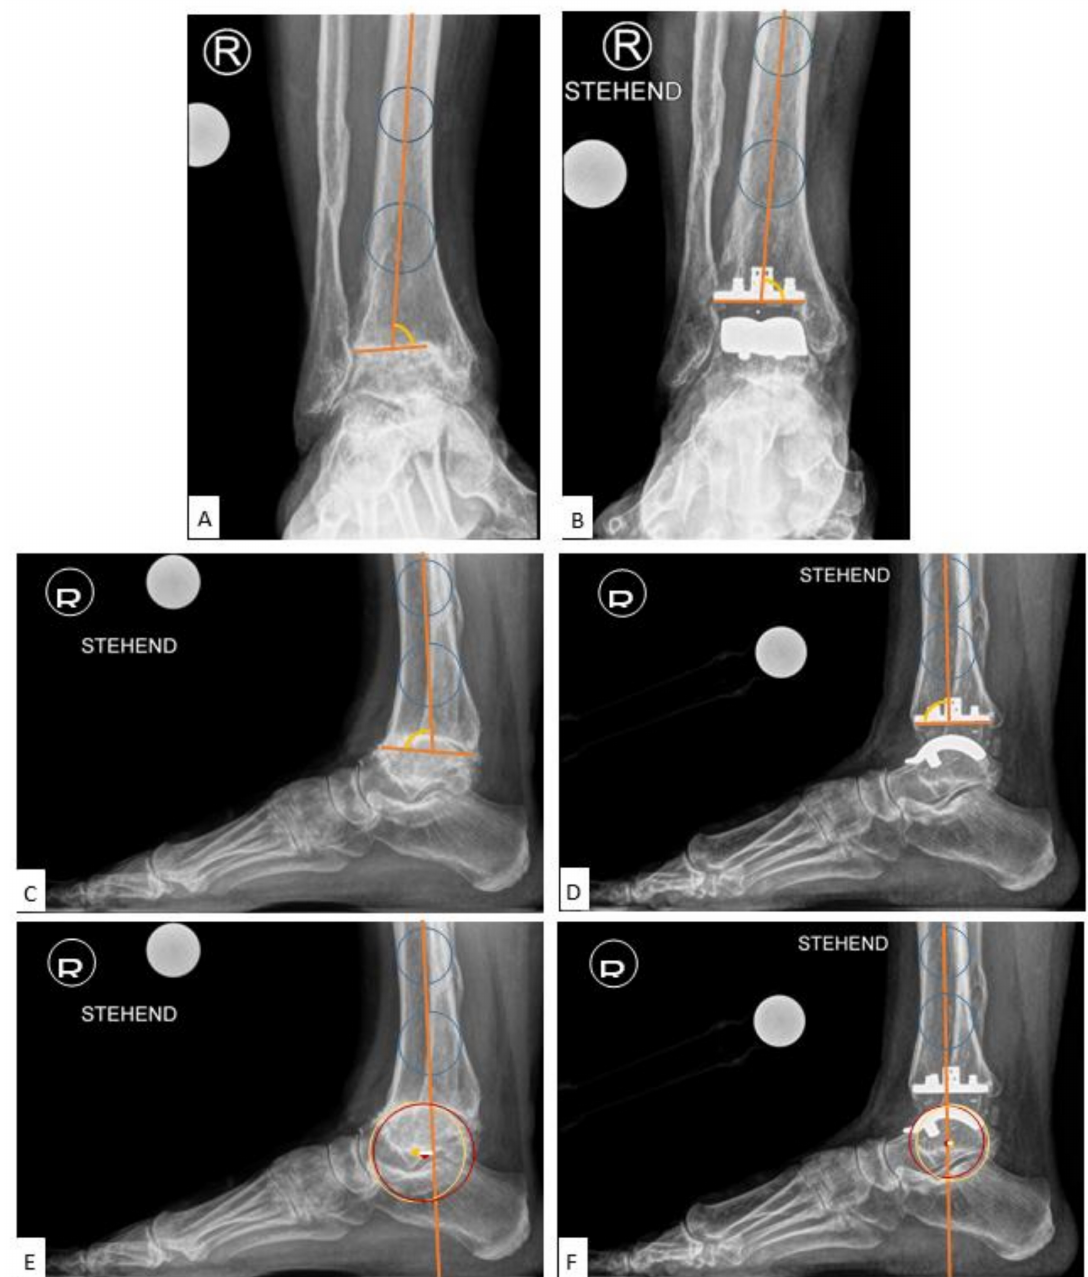
Figure 2. Preoperative and Postoperative Radiological Measurements. ( A ): Medial distal tibial articular angle (mDTAA) on the ankle osteoarthritis (OA), ( B ): Medial distal tibial articular angle (mDTAA) on the total ankle arthroplasty (TAA) as medial tibial component coronal angle, ( C ): Anterior distal tibial articular angle (aDTAA) on the ankle OA, ( D ): Anterior distal tibial articular angle (aDTAA) on the TAA as anterior tibial baseplate angle. Lateral talar station (LTS). ( E ): Preoperative on the ankle OA, ( F ): Postoperative on the